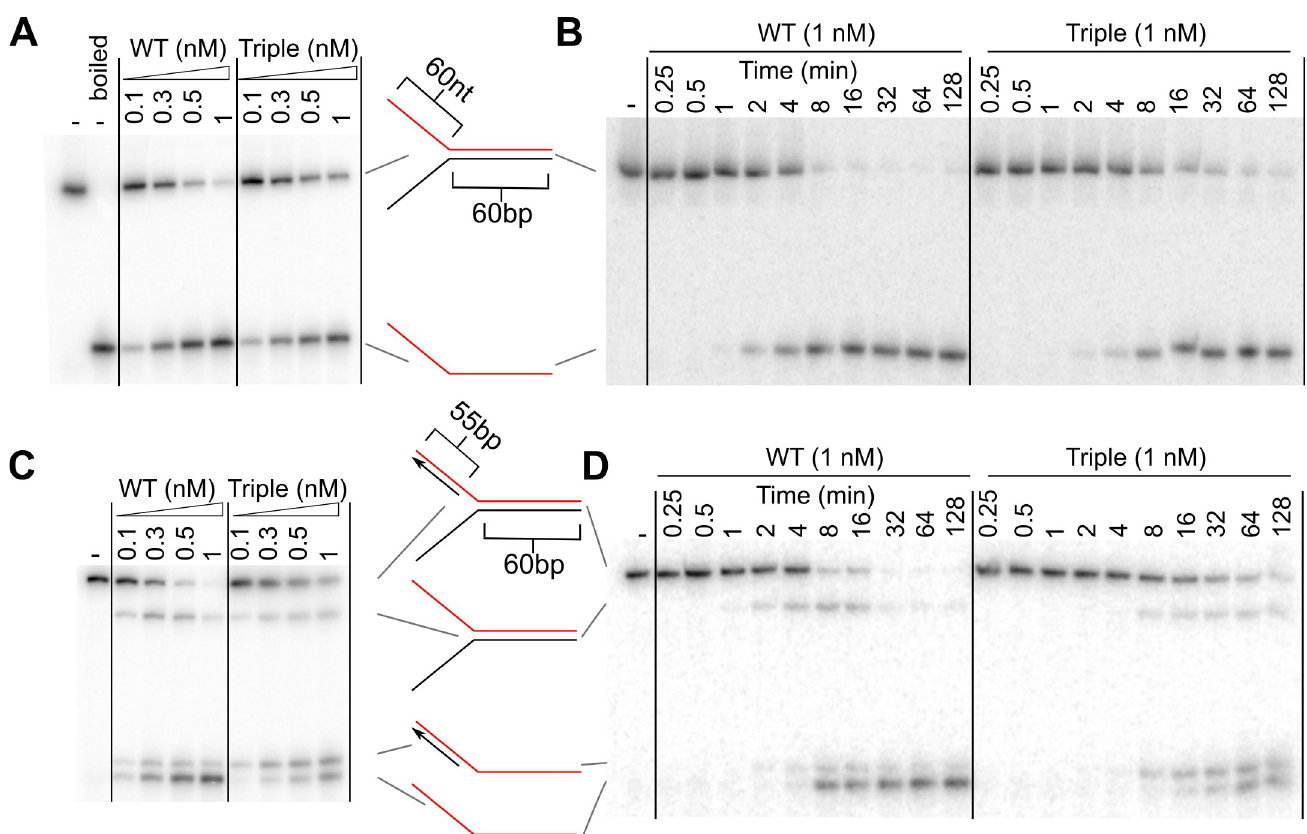
Fig 4. Triple linker variant can unwind parental duplex of extended forks. (A and B) Unwinding products from incubation of extended two-stranded fork (0.5 nM, molecules) with PriA variants at concentrations shown and 2mM ATP. Assays are shown as 30-minute end points (A) or time-course (B) experiments . (C and D) Unwinding products from incubation of extended three-stranded fork (0.5 nM, molecules) with PriA variants at concentrations shown and 2mM ATP. Assays are shown as 30-minute end points (C) or time-course (D) experiments. Substrates are depicted with radiolabeled strand shown in red. Gels are representative of at least three